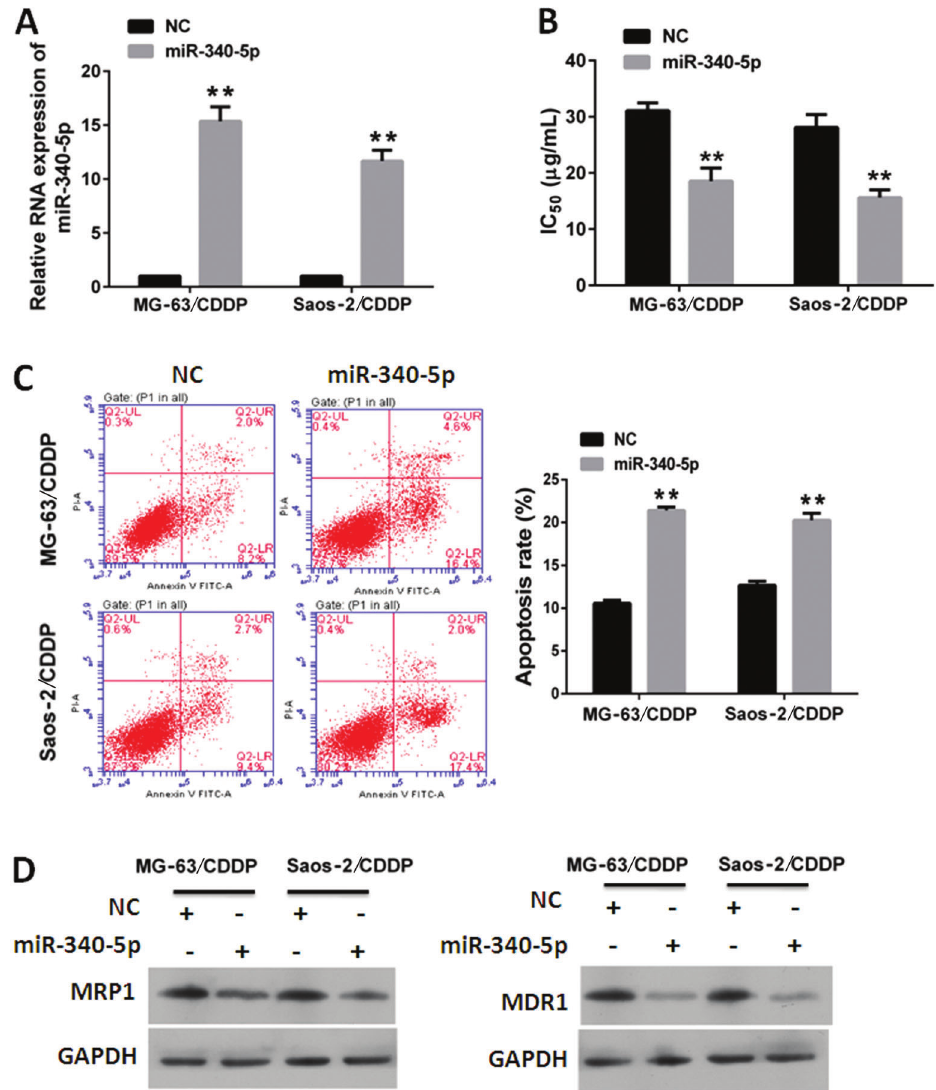
Figure 2. miR-340-5p enhanced sensitivity of cisplatin (CDDP) in osteosarcoma cells. A , Relative RNA expression of miR-340-5p in MG-63/CDDP and Saos-2/CDDP cells transfected with miR-340-5p or normal control (NC). B , miR-340-5p decreased IC 50 of CDDP in MG-63/CDDP and Saos-2/CDDP cells. C , miR-340-5p increased CDDP-induced apoptosis in MG-63/CDDP and Saos-2/CDDP cells. Data are reported as means ± SD. **P o 0.01 (Student ’ s t -test). D , miR-340-5p decreased the expression of MRP1 and MDR1 in MG-63/ CDDP and Saos-2/CDDP cells exposed to